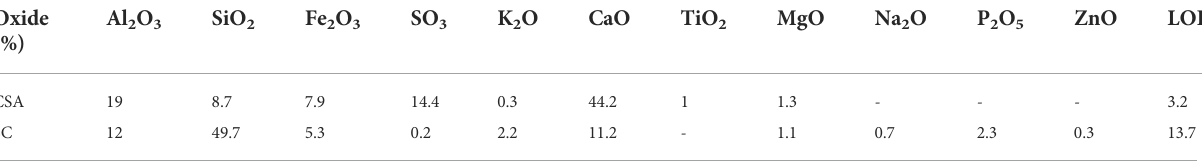
TABLE 2 Concentrations of the major oxide elements for the CSA cement Alpenat from VICAT and the fl ash-calcined sediment. Oxide